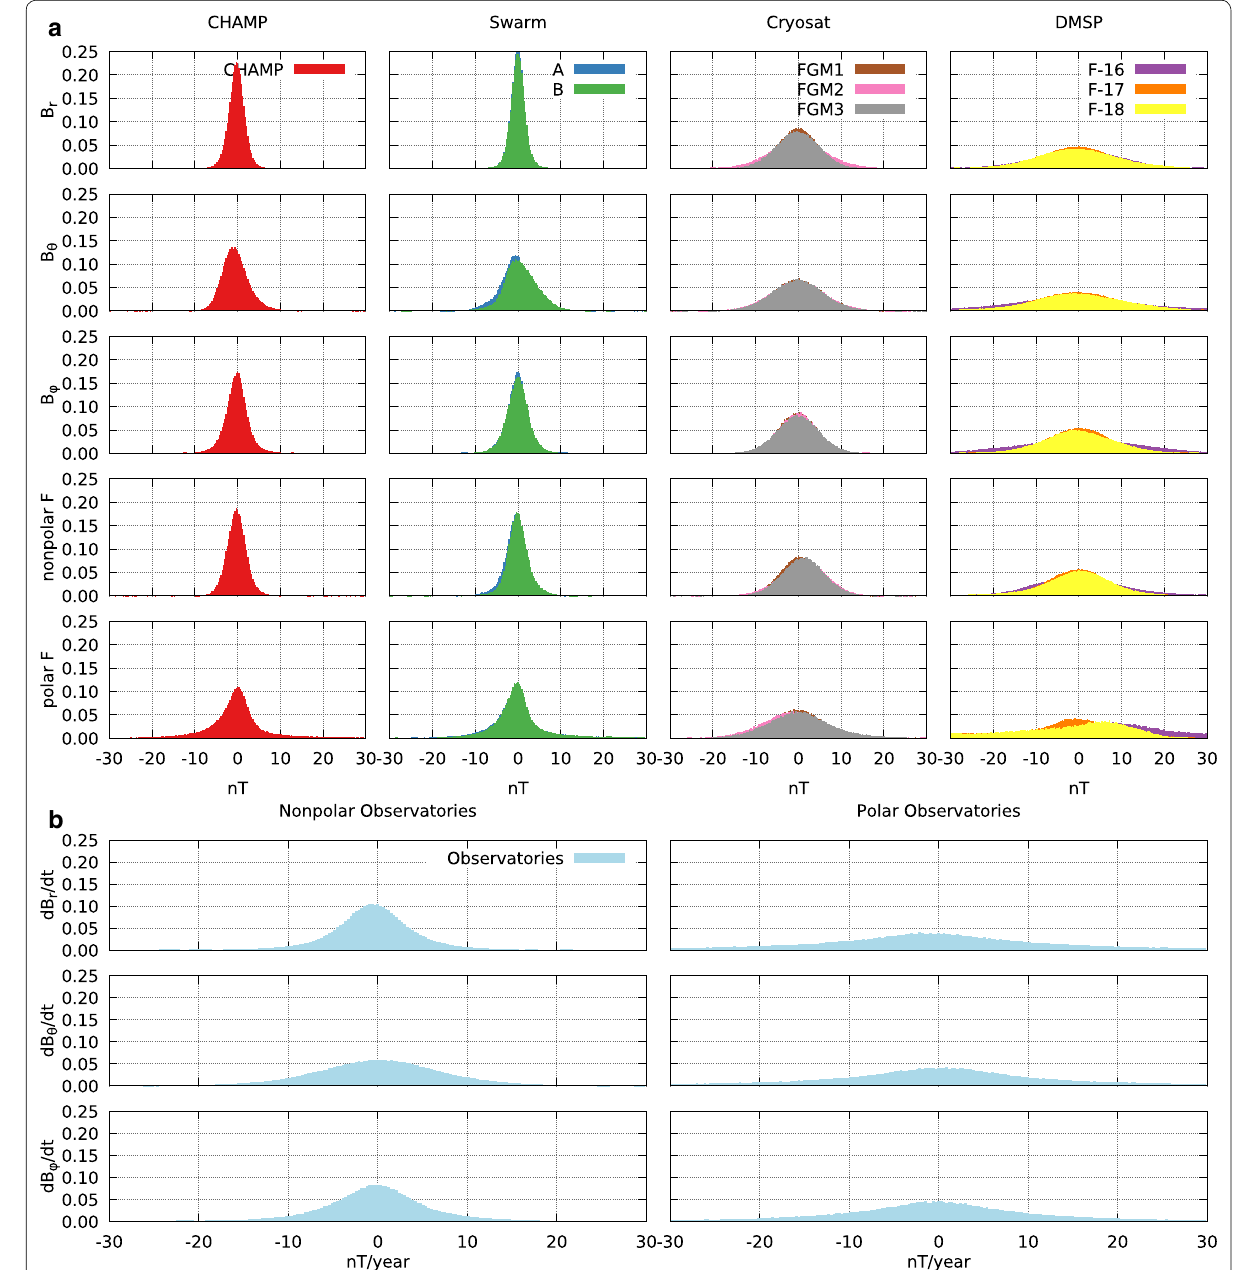
Fig. 4 a Residual histograms for all satellites and field components used in Model A. b Residual histograms for ground observatory secular variation dataset used in Model A. Histograms are normalized to have unit area. Nonpolar histograms are calculated from residual data equatorward of 55 ◦ QD latitude, while polar histograms use residuals poleward of 55